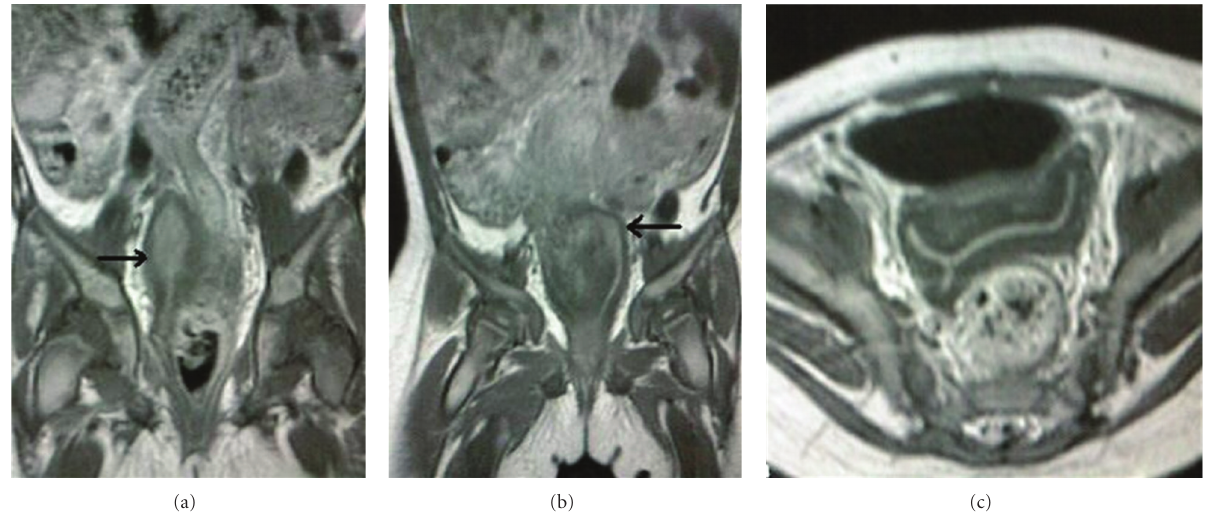
Figure 4: T1-weighed postoperative MR images. (a) and (b): two consecutive pelvic coronal images clearly show the two cavities (arrows) of the uterus separated by an incomplete longitudinal septum which was di ffi cult to depict earlier. (c) axial view through corpus shows bicornuate